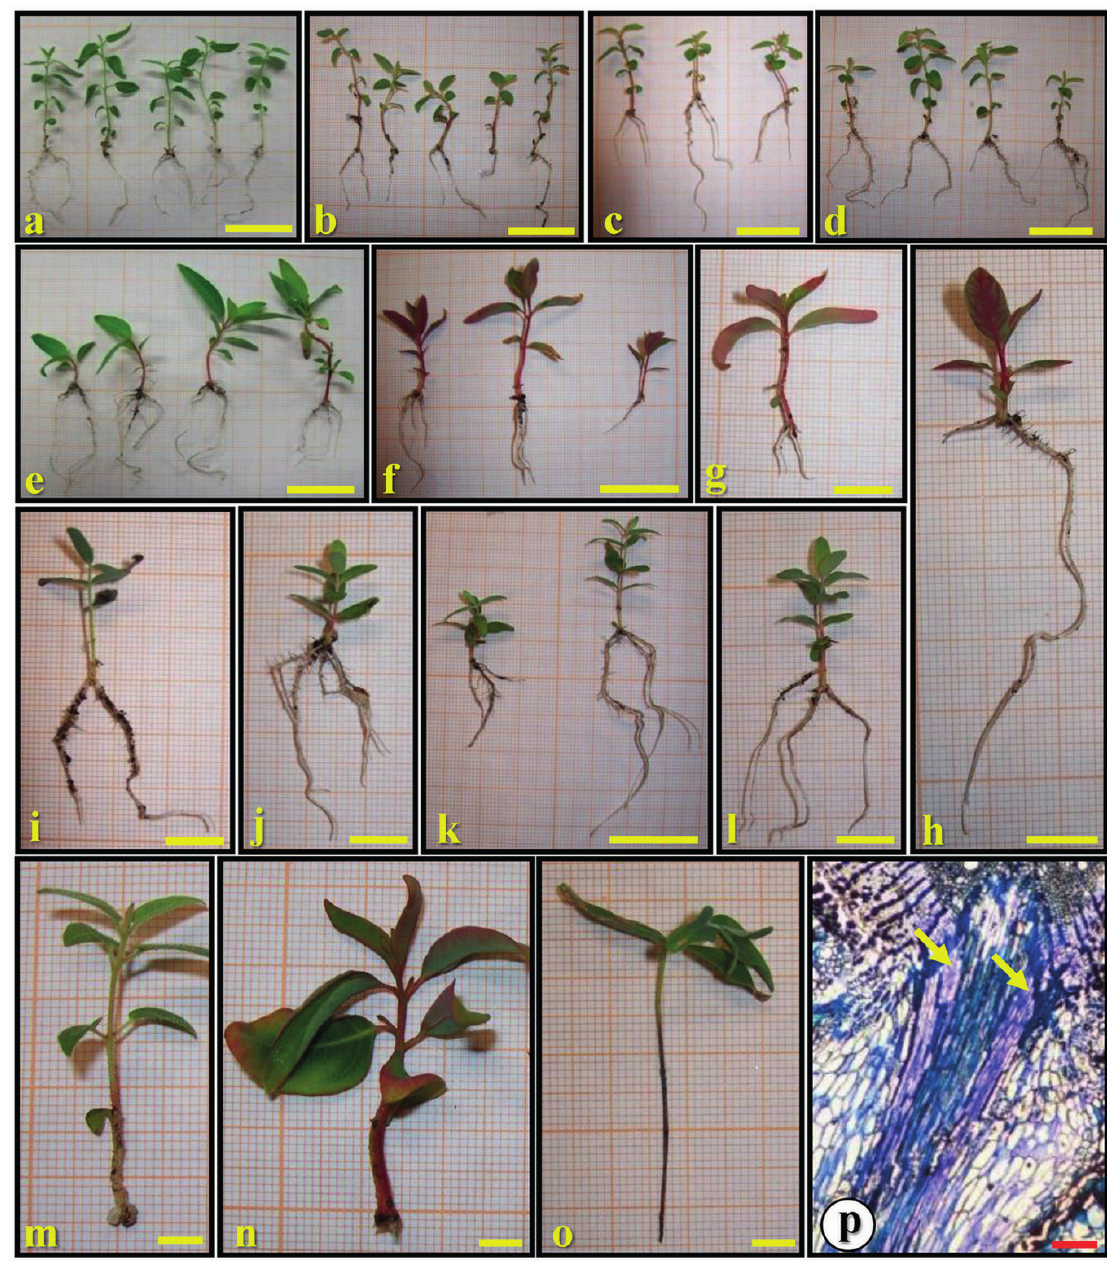
Figure 5 - Details of the adventitious rooting of Corymbia and Eucalyptus microcuttings in different environments of rooting. a – Corymbia citriodora in environments A